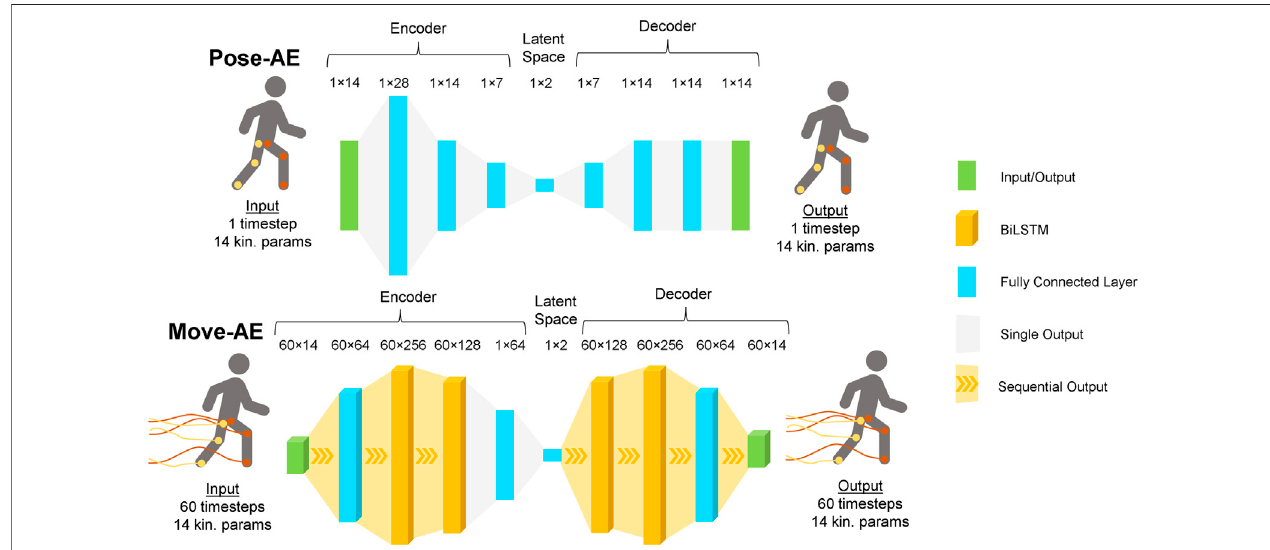
FIGURE 1 | Architecture for the Pose-AE network and Move-AE network. Both networks exhibit the classic autoencoder bottleneck shape. Whereas Pose-AE takes single poses as input, Move-AE makes use of stacked recurrent bidirectional LSTM layers to accept entire movement trajectories as input. Both networks embed each input as a single point in a two dimensional latent